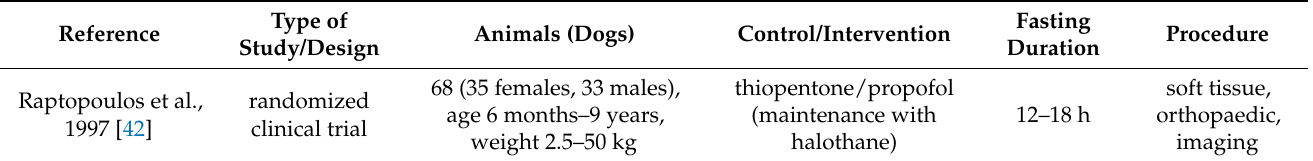
Table 2. Intervention: induction agent. Characteristics of the study in dogs.